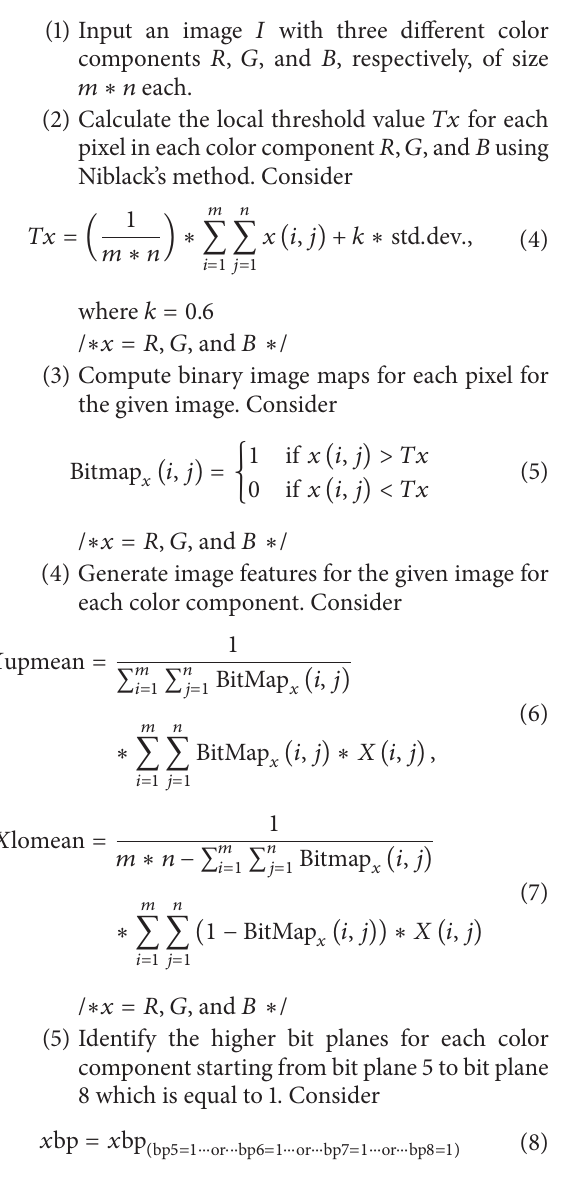
Figure 1: Bit planes represented by 8 bit binary vector.